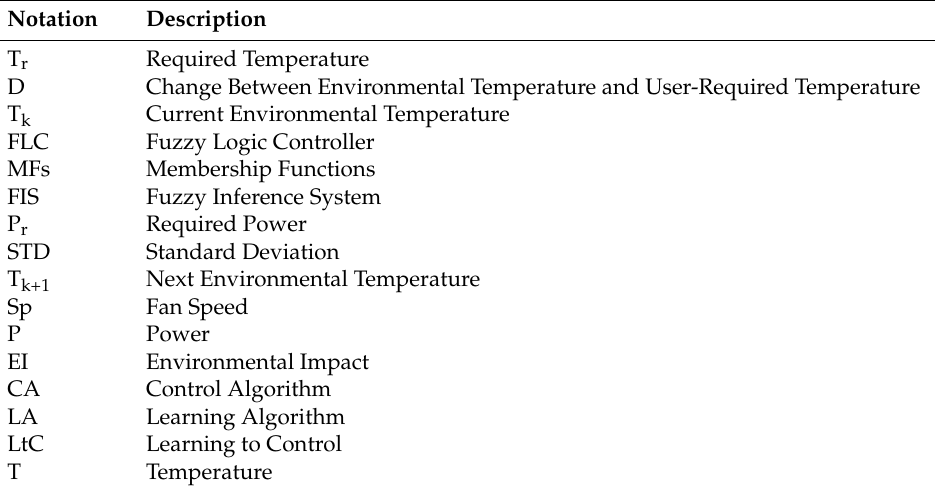
Table 1. Description of notations used in the